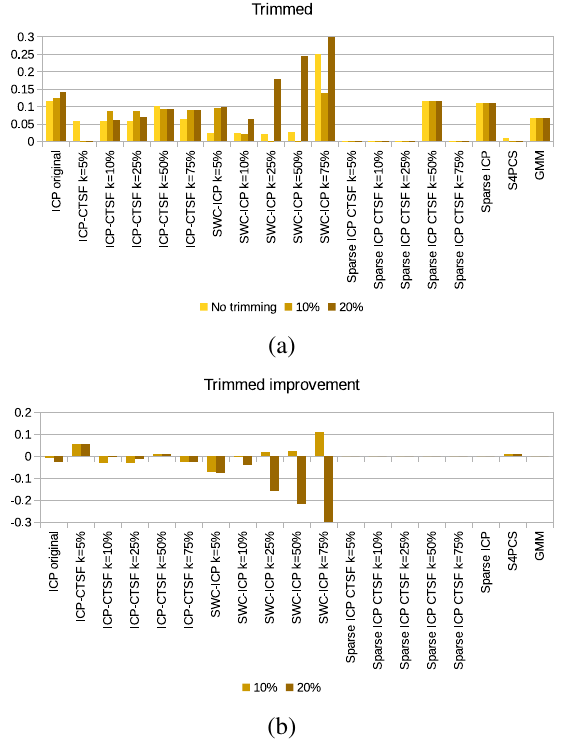
Fig. 11: Influence of the trimming parameter in the case 45 ◦ - 90 ◦ . (a) Rotation error according to φ 3 . (b) Visualization of the error variations, with respect to the trimming